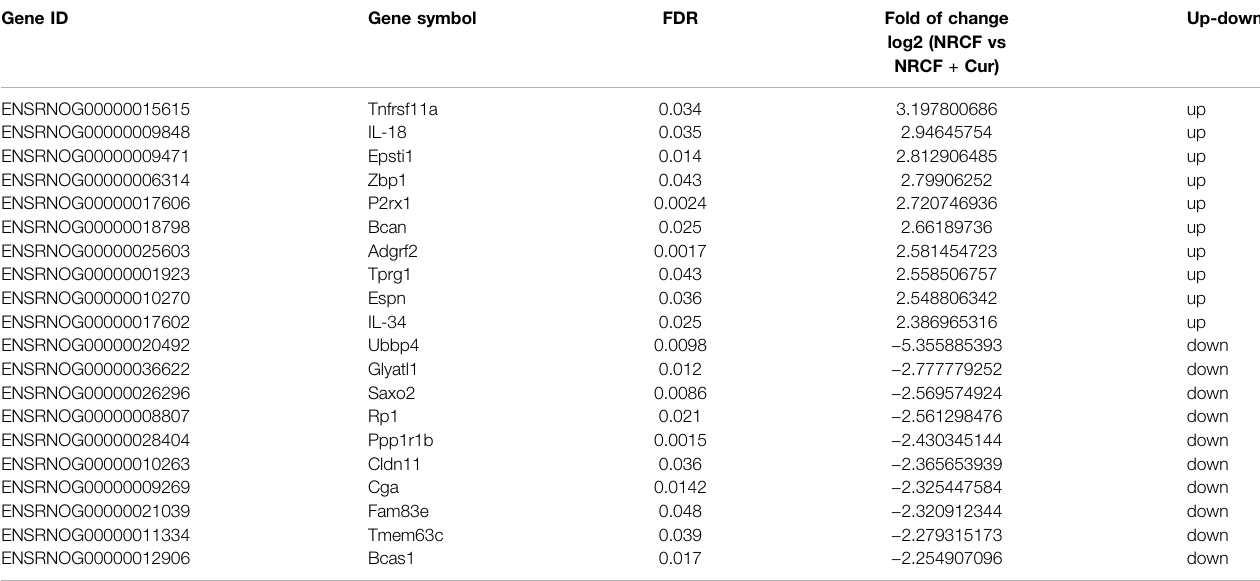
TABLE 1 | Top 10 up and down-regulated genes enriched in in fl ammation response pathway. (NRCF, co-cultured with PBS-treated macrophages with TGF- β , administration) vs (NRCF, co-cultured with curcumin-treated macrophages with TGF- β , administration). Gene ID Gene symbol FDR Fold of change